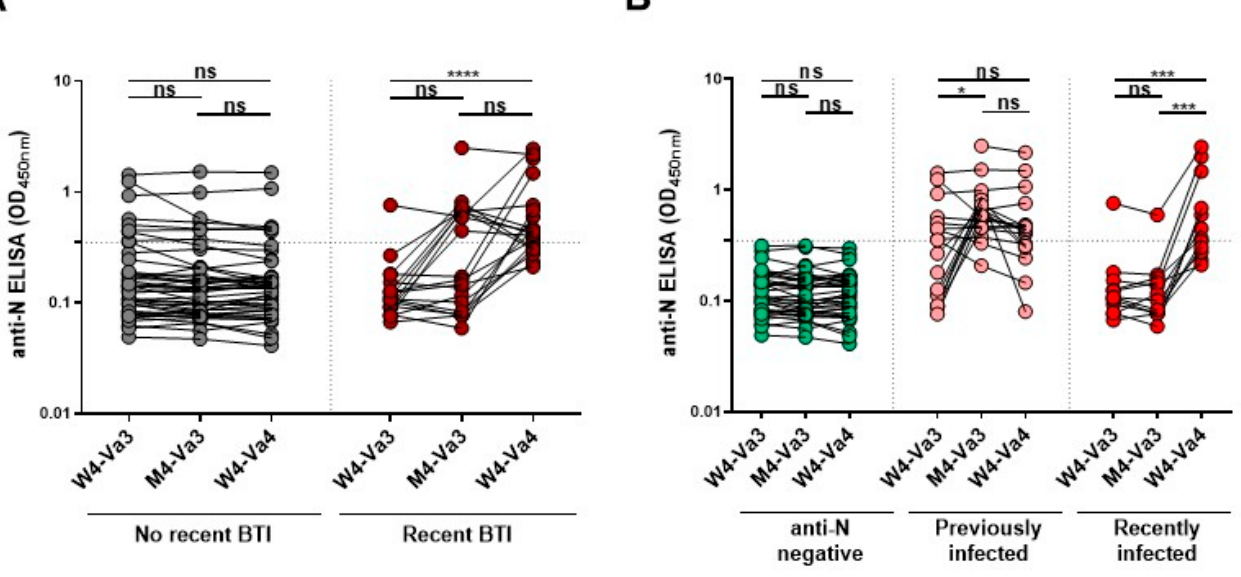
Figure 2. Anti-N level measured after the third and fourth doses of SARS-CoV-2 vaccine. Anti-N level was measured in plasma from vaccinated donors by ELISA. ( A ) Donors are considered to have a recent BTI when a significant increase in anti-N Abs level between W4-Va3 and M4-Va3 or between M4-Va3 and W4-Va4 is observed (ratio M4-Va3/W4-Va3 and/or ratio W4-Va4/M4-Va3 higher than 1.5), according to a recently described analytical approach based on the ratio of anti-N absorbance [18]. ( B ) Infections were defined using either the absorbance result of anti-N ELISA (cut-off for seropositivity of 0.350) for the W4-Va3 samples or the ratio-based approach [18] when two consec- utive samples were available (W4-Va3 and M4-Va3 or M4-Va3 and W4-Va4). Samples with absorb- ance below the cut-off at the W4-Va3 timepoint and no significant increase in anti-N absorbance ratio were included in the anti-N negative group ( n = 33). Individuals seropositive at W4-Va3 (ab- sorbance > 0.350) or with a significant increase in anti-N absorbance between W4-Va3 and M4-Va3 (ratio M4-Va3/W4-Va3 higher than 1.5) were included in the previously infected group ( n = 18). Finally, individuals with a significant increase in anti-N absorbance between the M4-Va3 and W4- Va4 (ratio > 1.5) were included in the recently infected group ( n = 12). Seropositivity thresholds are